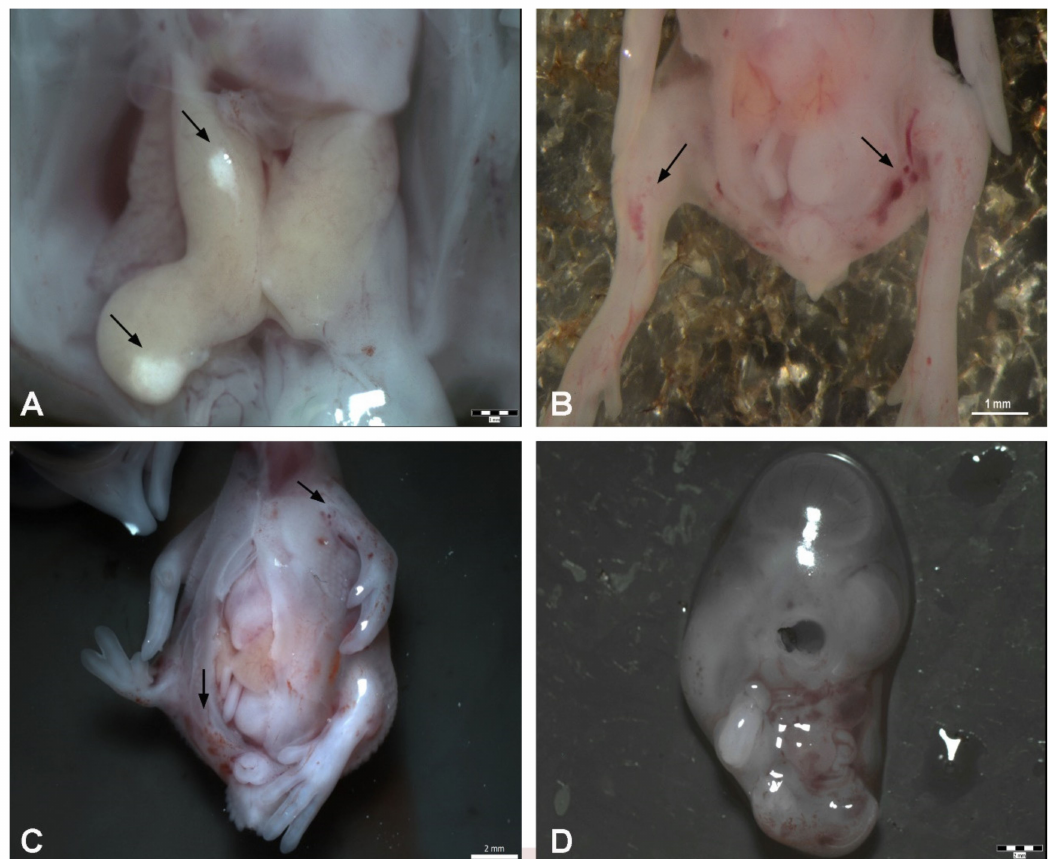
Figure 4. Malformations appearing after DMSO administration on ED 9. ( A ): Observation of local macroscopic colour changes on the liver after 10 µ L of DMSO administration, scale bar 1 mm, ( B ): Haemorrhages on the limb buds after 15 µ L of DMSO administration—arrows, scale bar: 1 mm, ( C ): Opening of the body wall, haemorrhages on the left-wing bud and pelvic region (arrows), malformation of the right limb bud—20 µ L of DMSO administration, scale bar: 2 mm, ( D ): Growth retardation–25 µ L of DMSO administration, scale bar: 2